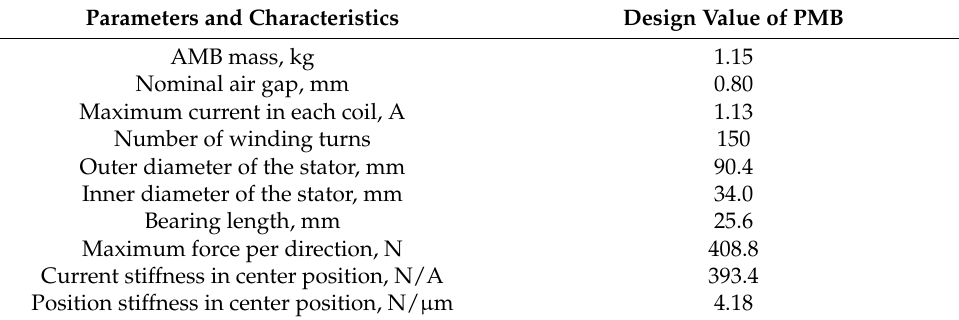
Table 2. Design parameters of the AMB.